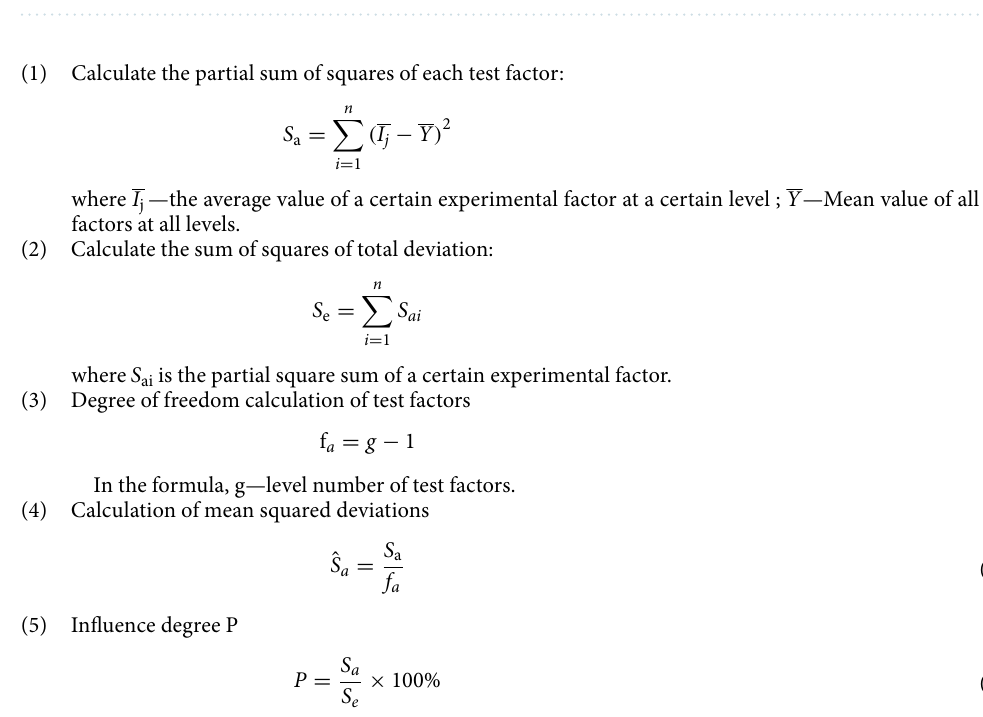
Figure 15. The optimized The second direction residual